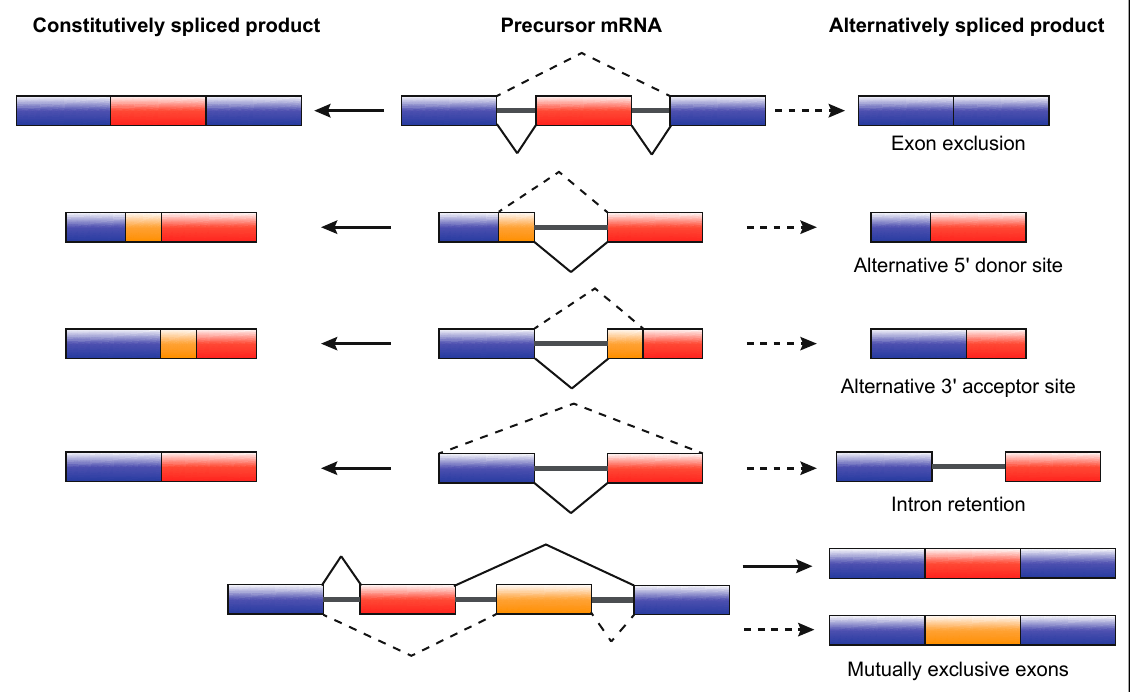
Figure 2. The main types of alternative mRNA splicing. Precursor mRNA can undergo either constitutive or alternative splicing. Constitutive splicing products (left) lack introns and comprise whole exons in the same sequence as the precursor mRNA (middle). Depending on the type of alternative splicing, different products can be yielded (right). Exon exclusion, and alternative 5 ′ and 3 ′ splice site selection result in a truncated transcript. Intron retention produces an elongated transcript, as the intron is not excised. Mutually exclusive exons do not occur together in mature mRNA during splicing and produce separate isoforms.